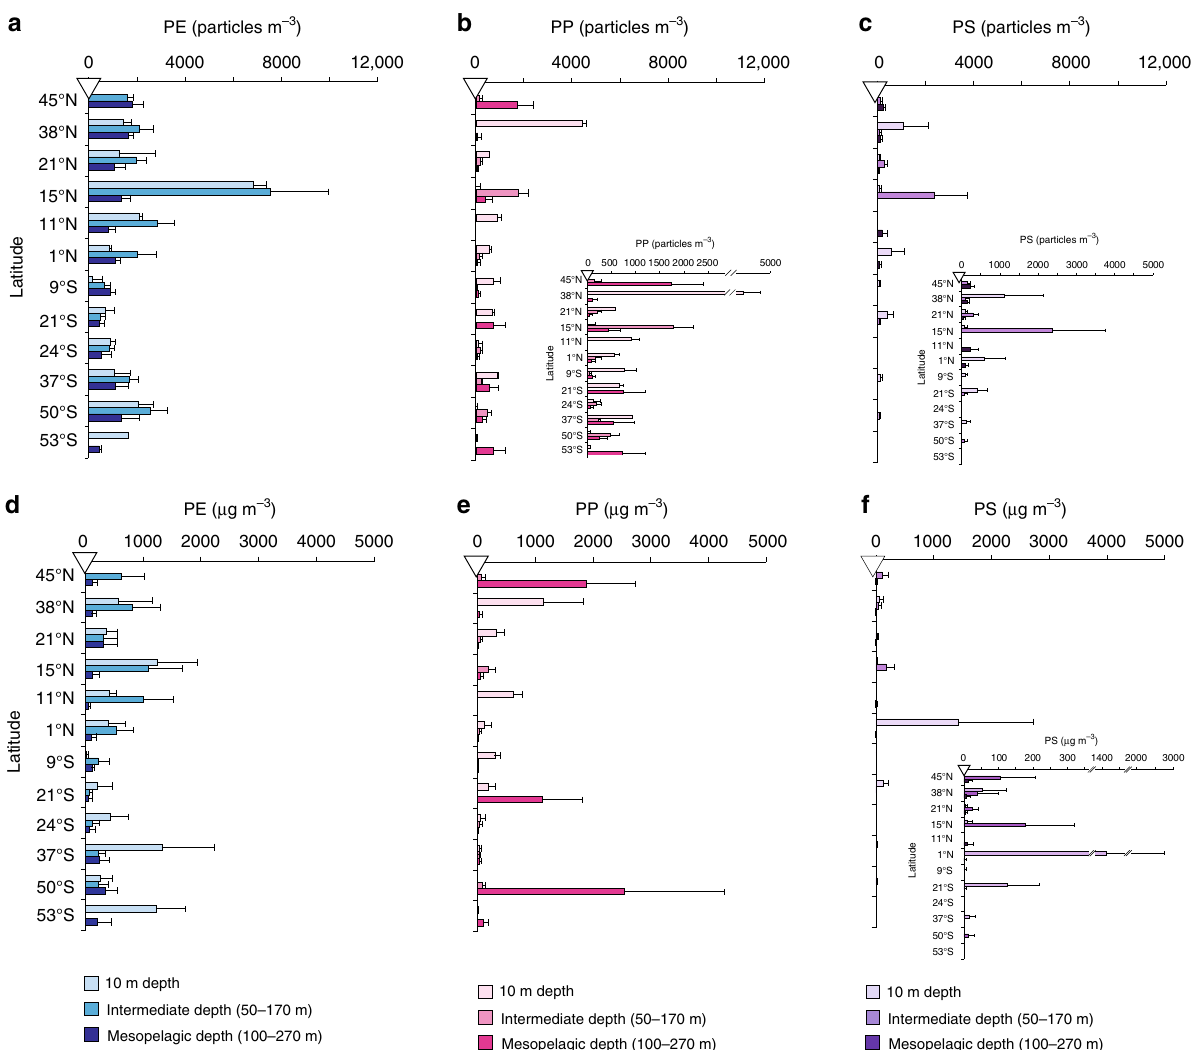
Fig. 2 Microplastics abundance in the study area. a – c particle number concentrations (particles m − 3 ) and d , e mass concentrations ( µ g m − 3 ) of the polymer groups at each station and depth layer. No near surface (10 m) sample was taken at 45°N (marked with white triangle) due to pump failure. In a – c , the height of the bar shows the particle number concentration derived from the mean microplastic count in four imaged areas of a sample 24 and scaled to the known total area fi ltered and the known sample volume of the investigated sample fraction (see ‘ Methods ’ and Supplementary Data 1). In d – f , the height of the bar shows the mass concentration of microplastic derived from particle number concentration data and two-dimensional properties of detected individual particles using Method IV (ref. 10 ; see Supplementary Methods and Supplementary Data 1). All error bars are one standard deviation showing uncertainty propagated through the calculations. Only upper error bar ( + 1 s.d.) is shown for clarity. Note a magni fi ed scale for concentrations of polypropylene ( b ) and polystyrene ( c , f